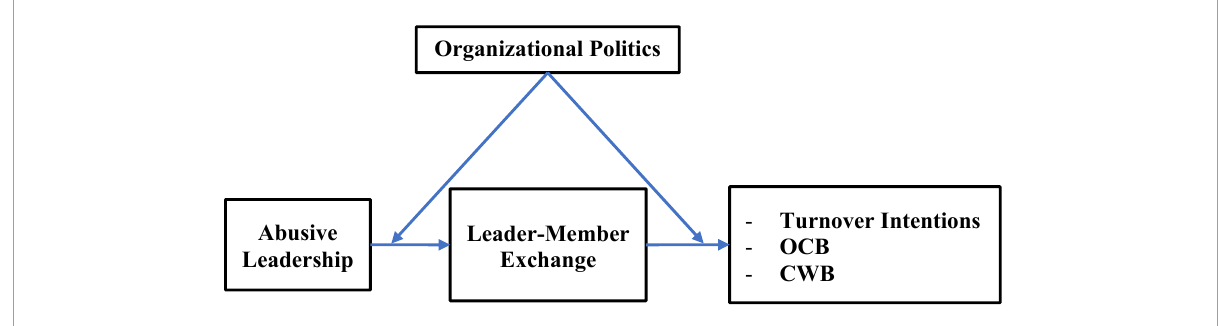
FIGURE1 Research model. OCB, organizational citizenship behavior; CWB, counterproductive work